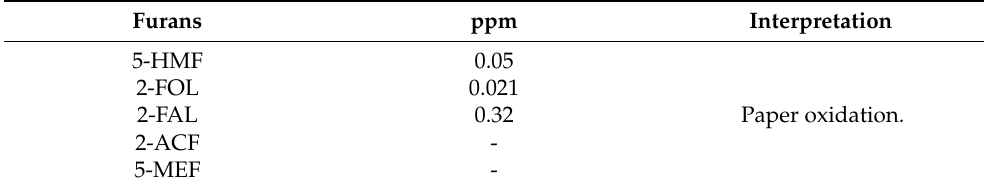
Table 17. Analysis of furans and their